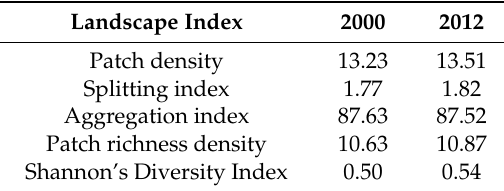
Table 3. The landscape index of 2000 and